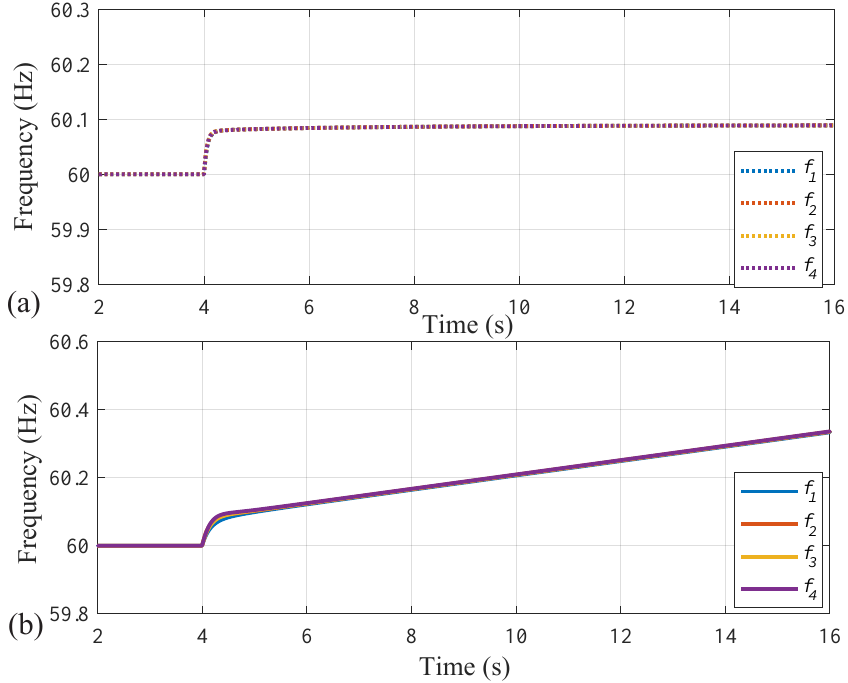
Figure 4. Frequency response under unbounded actuator attacks: ( a ) proposed resilient method and ( b ) conventional control